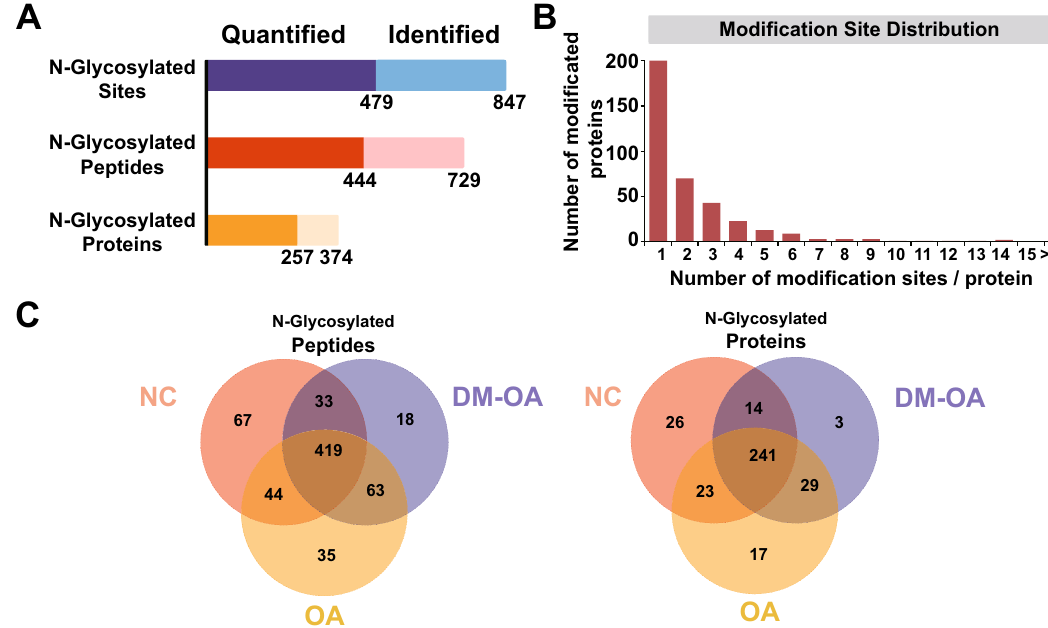
Figure 1. N-glycoproteome profiling analysis of human OA, OA with T2MD and control brain cartilage. ( A ) The total number of N-glycosylation sites, N-glycosylated peptides and their corresponding proteins identified in this study. ( B ) The distribution of N-glycosylation sites in N-glycosylated proteins. ( C ) Venn diagrams of identified N-glycosylated proteins and peptides indicating the number of overlapping genes in three separate pairwise comparisons.